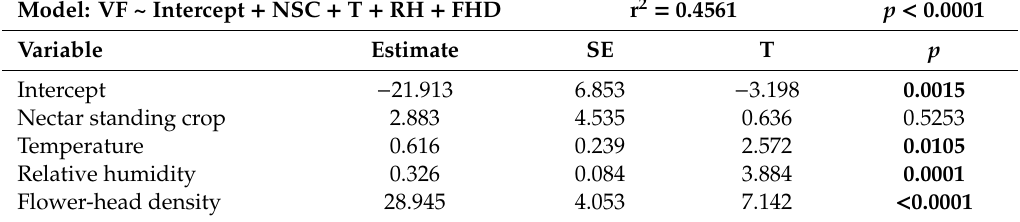
Table 4. Results of the linear model (LM) considering direct and indirect drivers of visitation frequency. The best model and its statistics can be found on the first line of the table: VF = visitation frequency, NSC = nectar standing crop, T = temperature, RH = relative humidity, FHD = flower-head density. The statistics for the individual variables of the best model are given in the rows that follow. Significant values are shown in